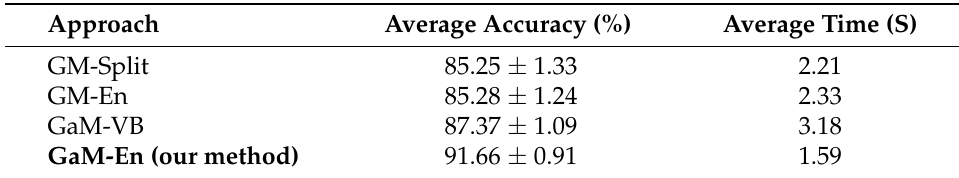
Table 2. The average recognition rate (% ± standard error) of hand gestures, using different ap- proaches, performed on Cambridge-Gesture